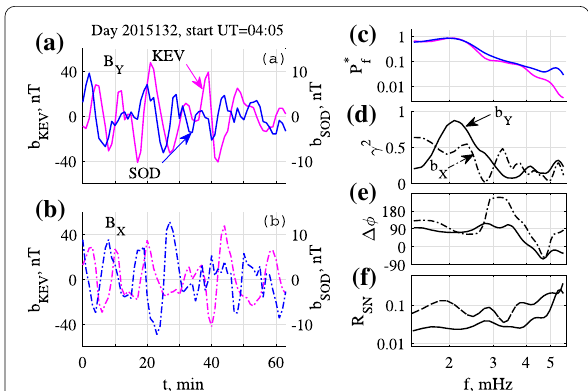
Fig. 7 Parameters of the event 2 pulsation in the N–S direction: a , b B Y and B X waveforms at KEV (magenta) and SOD (blue), note different vertical scale for two stations; c normalized PSD spectra; d , e N–S spectral coherence and phase difference for B Y (solid) and B X (dashed); f South-to-North PSD ratio for B Y (solid) and B X (dashed)